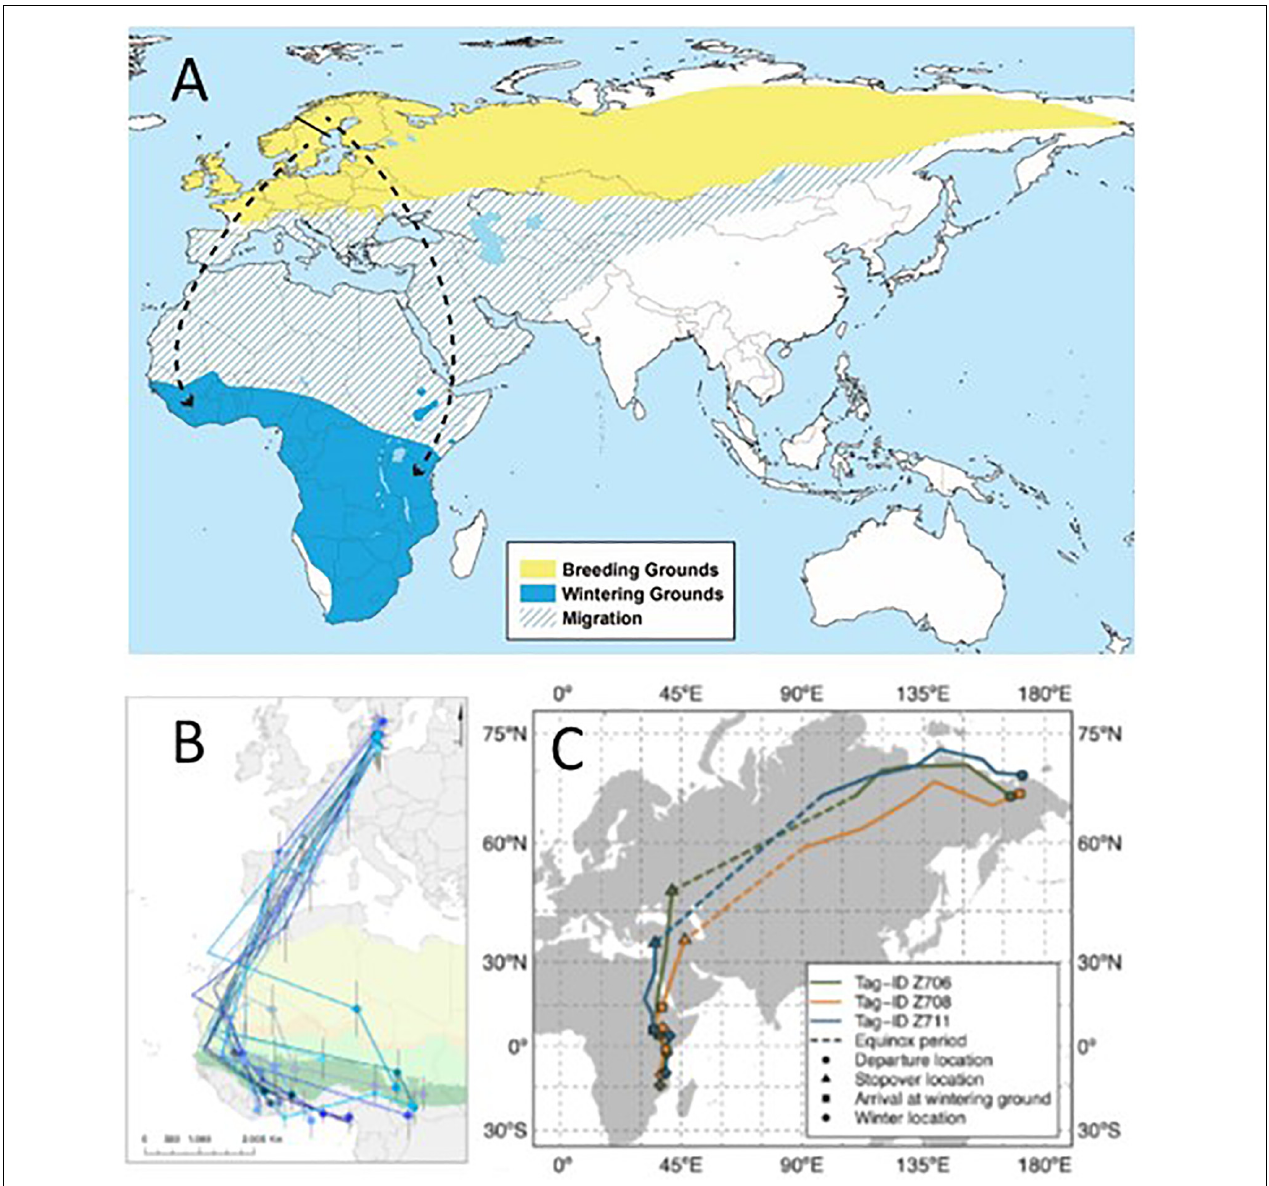
FIGURE 10 | Consistent, population-specific migration routes of Willow Warblers. (A) Worldwide distribution of Willow Warblers. Breeding (yellow) and wintering (blue) ranges and occurrence during migration (hatched). Arrows (broken black) indicate the expected migratory routes of Scandinavian southwest-migrating trochilus and southeast-migrating acredula Willow Warblers, and their approximate initial wintering areas in sub-Saharan Africa. Black bar indicate location of hybrid zone between acredula (north) and trochilus (south) in Scandinavia (Bensch et al., 2009; map courtesy Keith W. Larson, Sweden; Wikimedia.org). (B) Migration of southwest-migrating trochilus Willow Warblers from breeding to wintering grounds (individuals represented by different colors; from Lerche-Jørgensen et al., 2017). (C) Migration of P. t. yakutensis tracked by geolocation from breeding sites in Far East Russia to initial wintering areas in East Africa. From Sokolovskis et al.